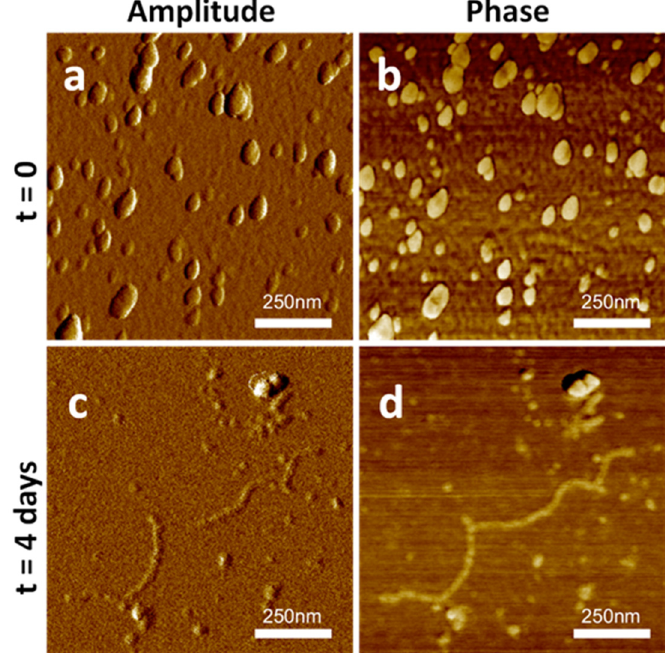
Figure 4. AFM imaging of 100 µ g / mL SAP -Pc in 10 mM phosphate buffer pH 7 after washing: Non-contact mode (NCM) amplitude (left column) and phase (right column) at t 0 ( a , b ) and after 4 days ( c , d ).